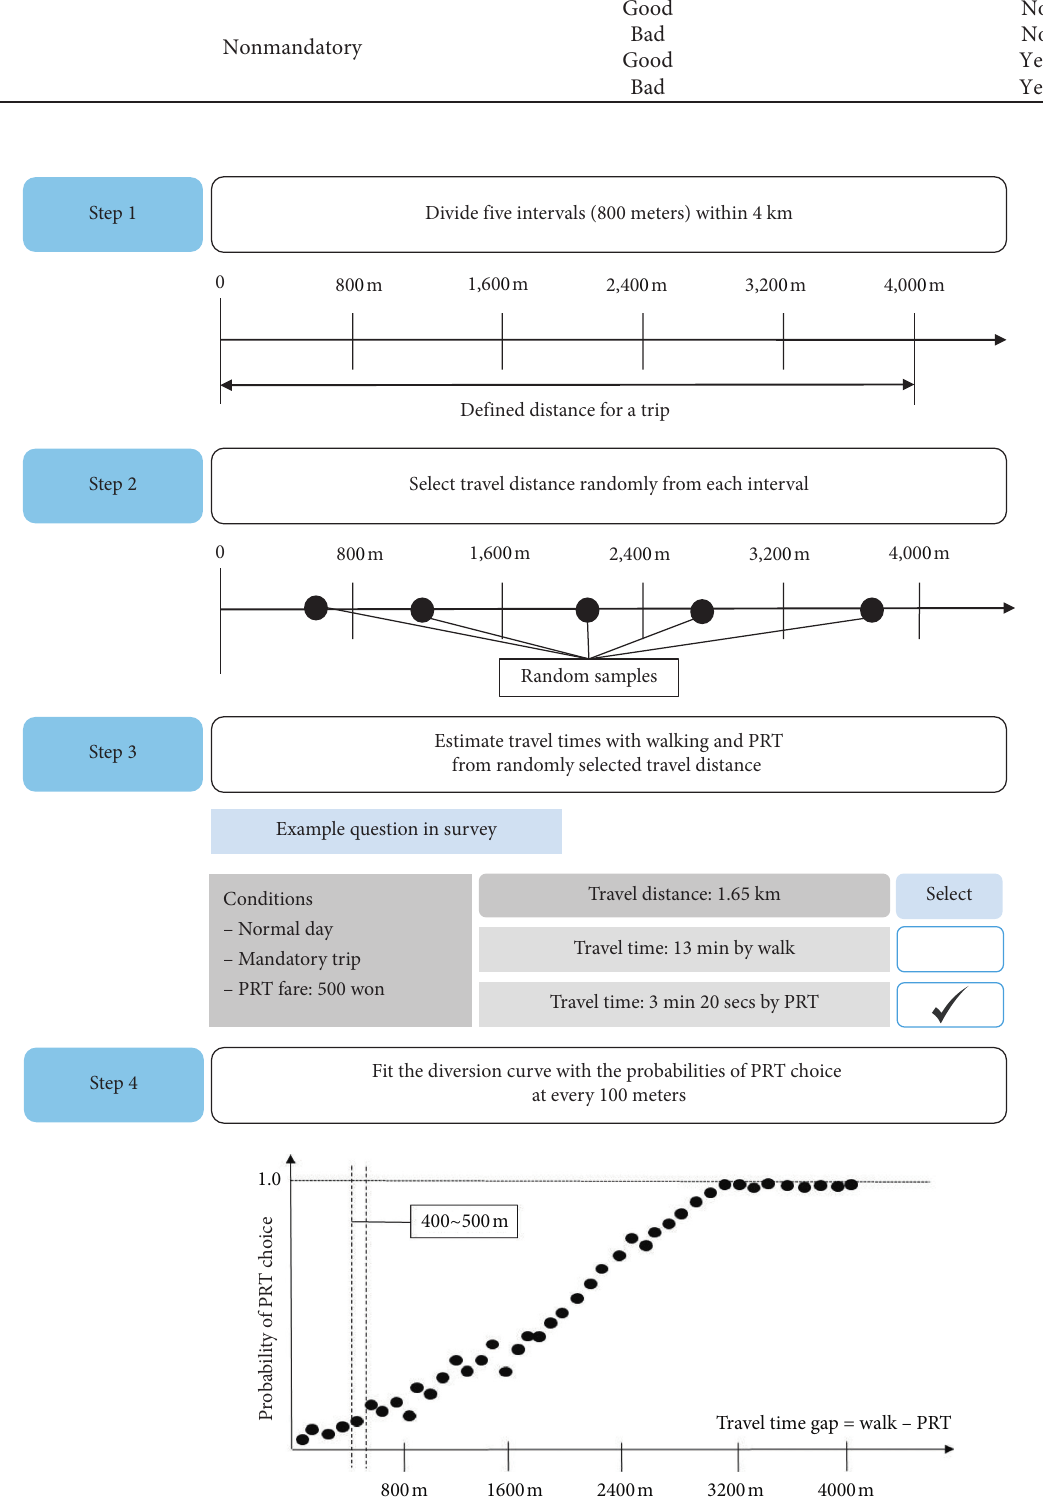
Figure 5: Process of developing mode choice